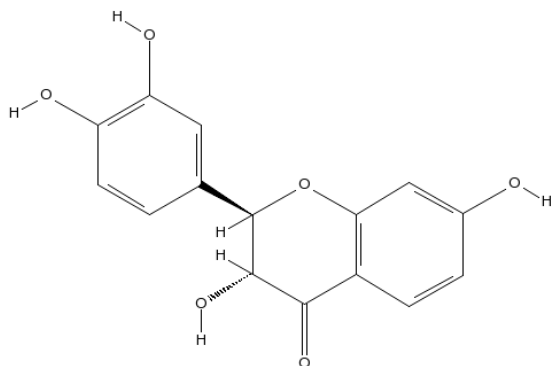
Figure 1. Fustin